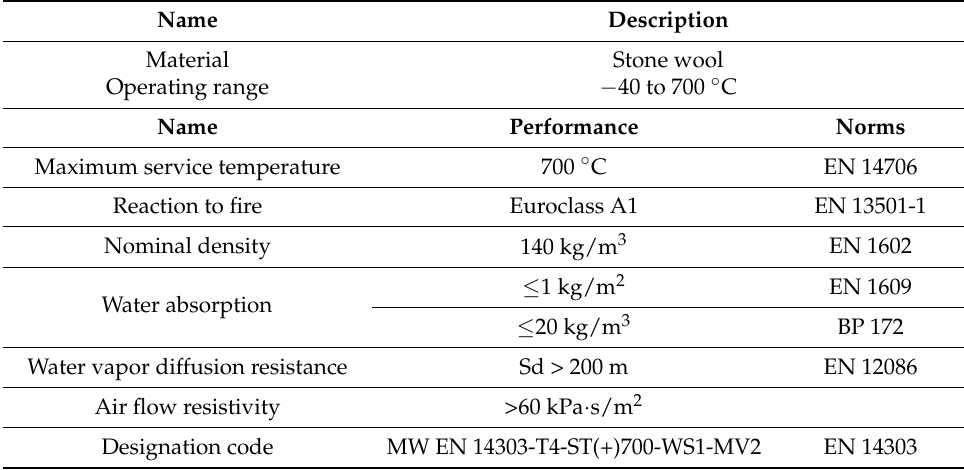
Table A1. Technical data for the Rockwool Pipe section mat thermal insulation.